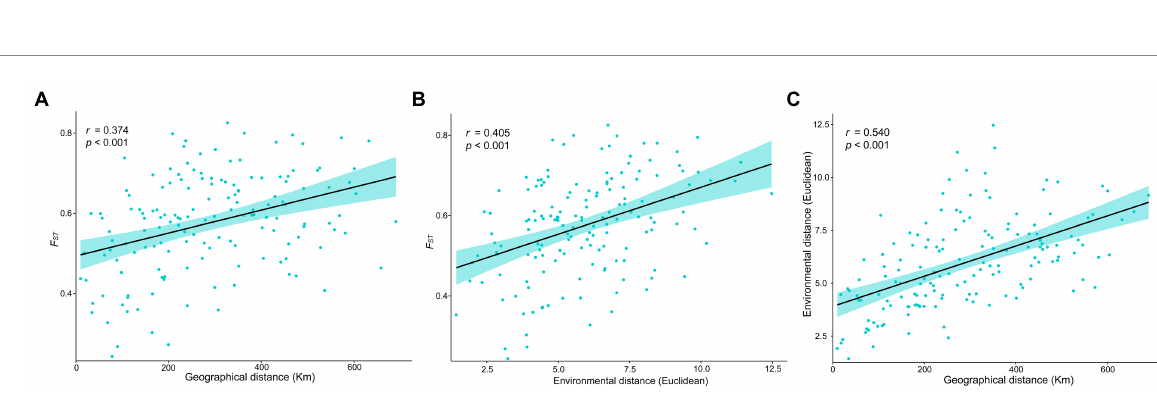
FIGURE 7 Linear regressions showing pairwise genetic, geographic, and environmental distances among the E. breviaristatus populations. (A) Regression showing genetic differentiation ( F ST ) and geographic distance. (B) Regression showing genetic differentiation ( F ST ) and environmental distance. (C) Regression showing geographic distance and environmental distance. Correlation coefficients and p -values are shown in the upper left-hand corner of each